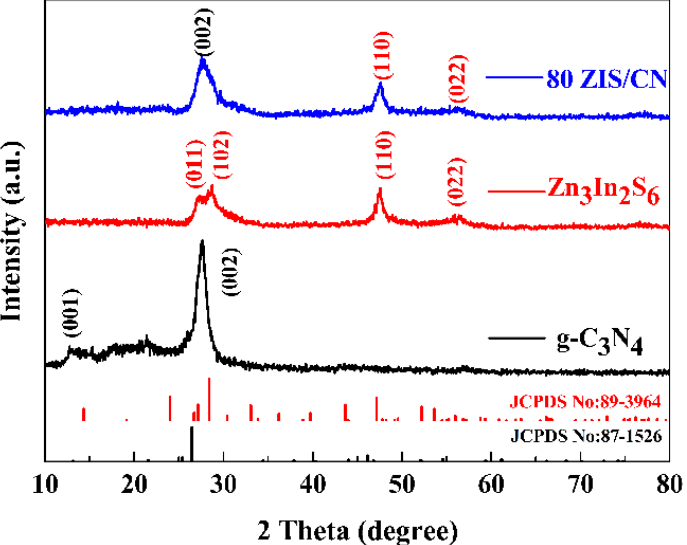
Figure 1. XRD patterns of g ‐ C 3 N 4 nanosheets, Zn 3 In 2 S 6 and binary 80 ZIS/CN heterostructure.